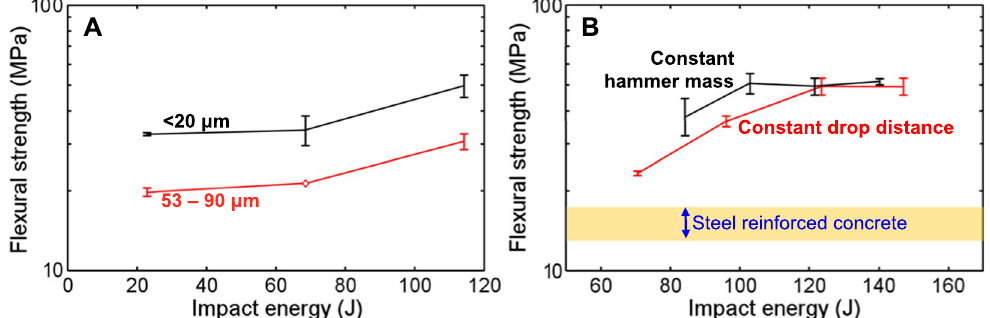
Figure 3. ( A ) Flexural strength of compacted Mars-1a as a function of the impact energy; the lateral boundary is free during the impact. The two series are labeled with their initial particle sizes; they obey similar trends, with the smaller particle size resulting in a higher strength. Impact energy was varied by adjusting the drop distance. ( B ) The flexural strength of compacted Mars-1a as a function of the impact energy; the lateral boundary is flexible during the impact; the initial particle size is 25–45 μ m. The two series are distinguished apart by either controlling the hammer mass or the drop distance to adjust the impact energy. Typical range of flexural strength of steel-reinforced concrete is shown for comparison 37